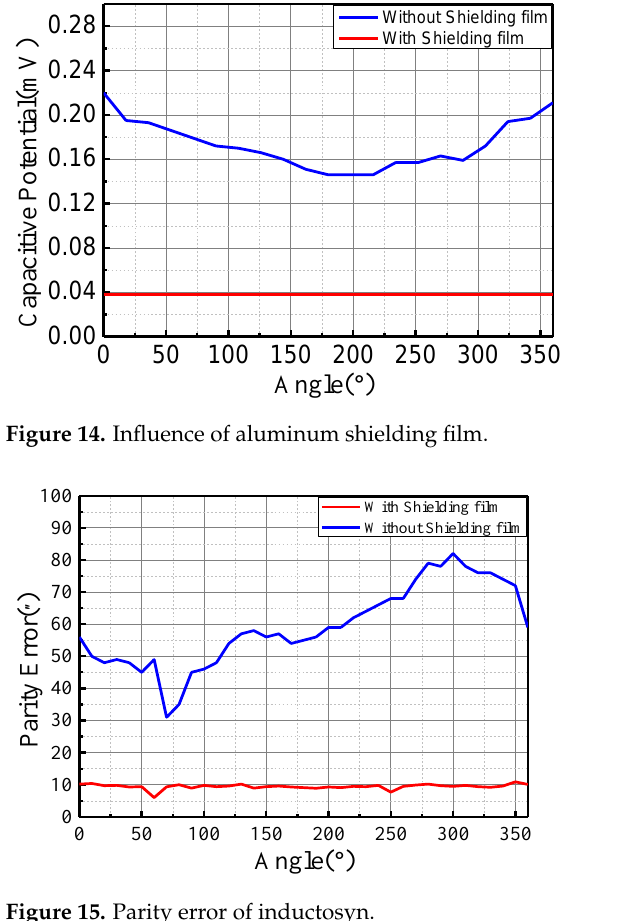
Figure 14. Influence of aluminum shielding film.